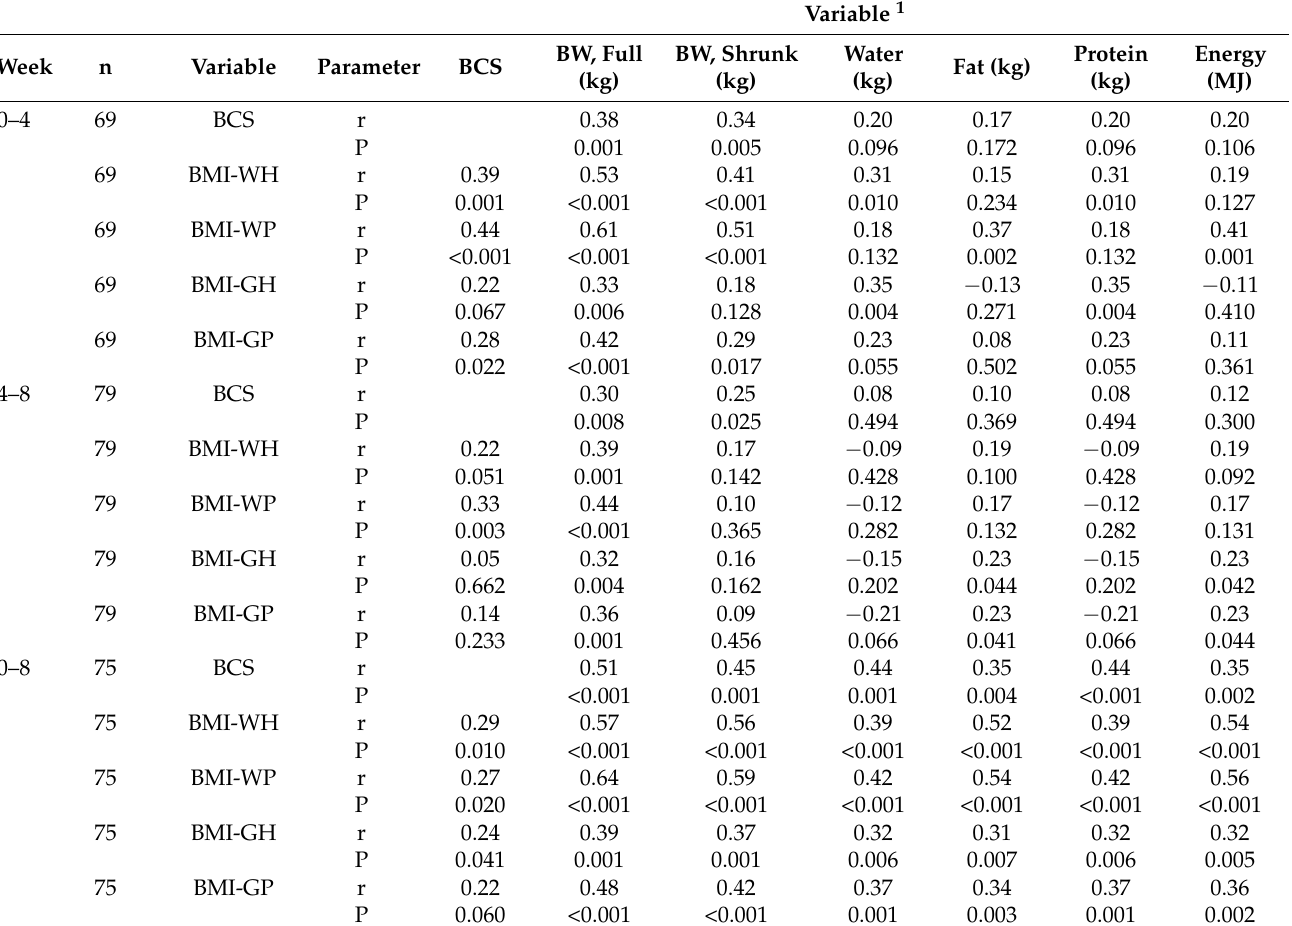
Table 9. Pearson correlation coefficient (r) between changes during 4 or 8 wk in body condition score, body mass indexes, body weight, and body composition of hair sheep based on urea